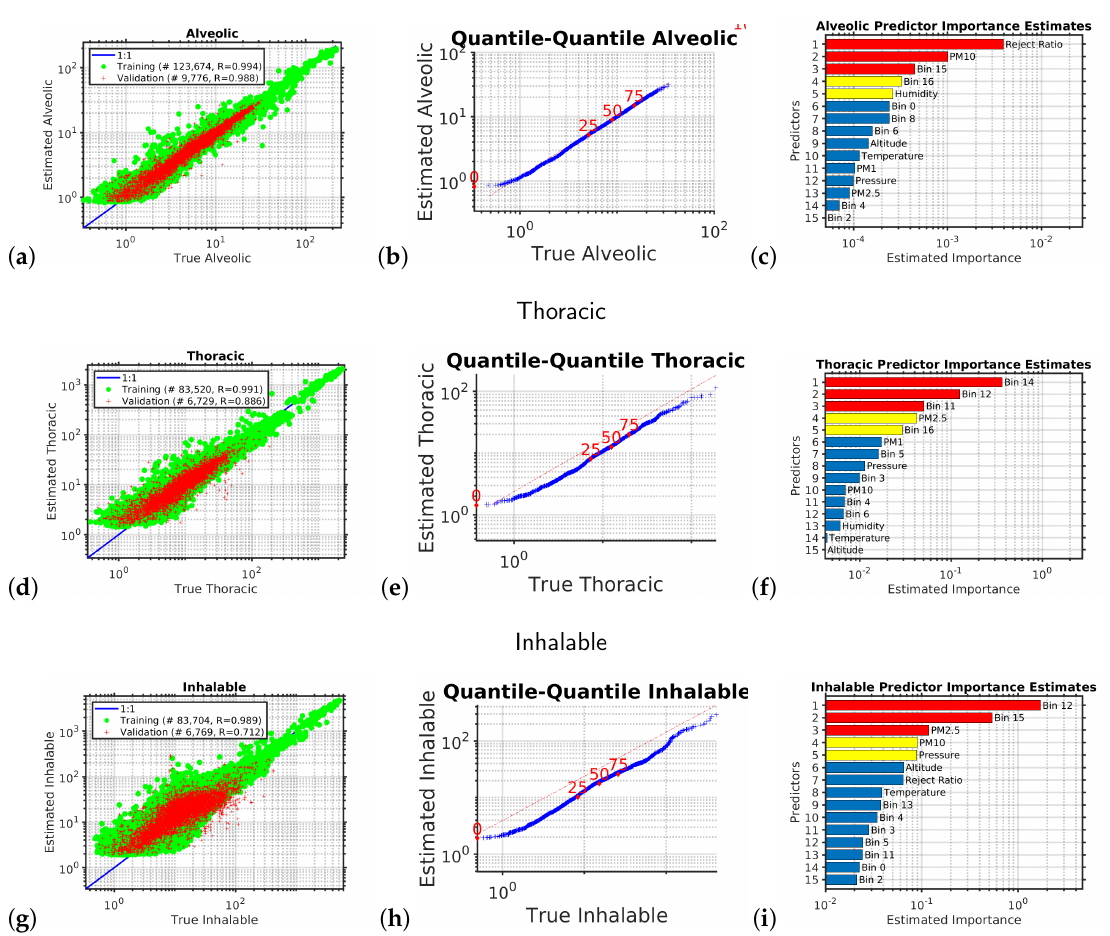
Figure 2. This figure shows the results of the multivariate non-linear non-parametric machine learning regression for the alveolic (panels ( a )–( c )), thoracic (panels ( d )–( f )), and inhalable size fractions (panels ( g – i )). The left hand column of plots shows the log–log axis scatter diagrams with the x-axis showing the PM abundance from the expensive reference instrument and the y-axis showing the PM abundance provided by calibrating the low-cost instrument using machine learning. The green circles are the training data; the red pluses are the independent validation dataset. The blue line shows the ideal response. The middle column of plots shows the quantile–quantile plots for the machine learning validation data, with the x-axis showing the percentiles from the probability distribution function of the PM abundance from the expensive reference instrument and the y-axis showing the percentiles from the probability distribution function of the estimated PM abundance provided by calibrating the low-cost instrument using machine learning. The dotted red line shows the ideal response. The right hand column of plots shows the relative importance of the input variables for calibrating the low-cost optical particle counters using machine